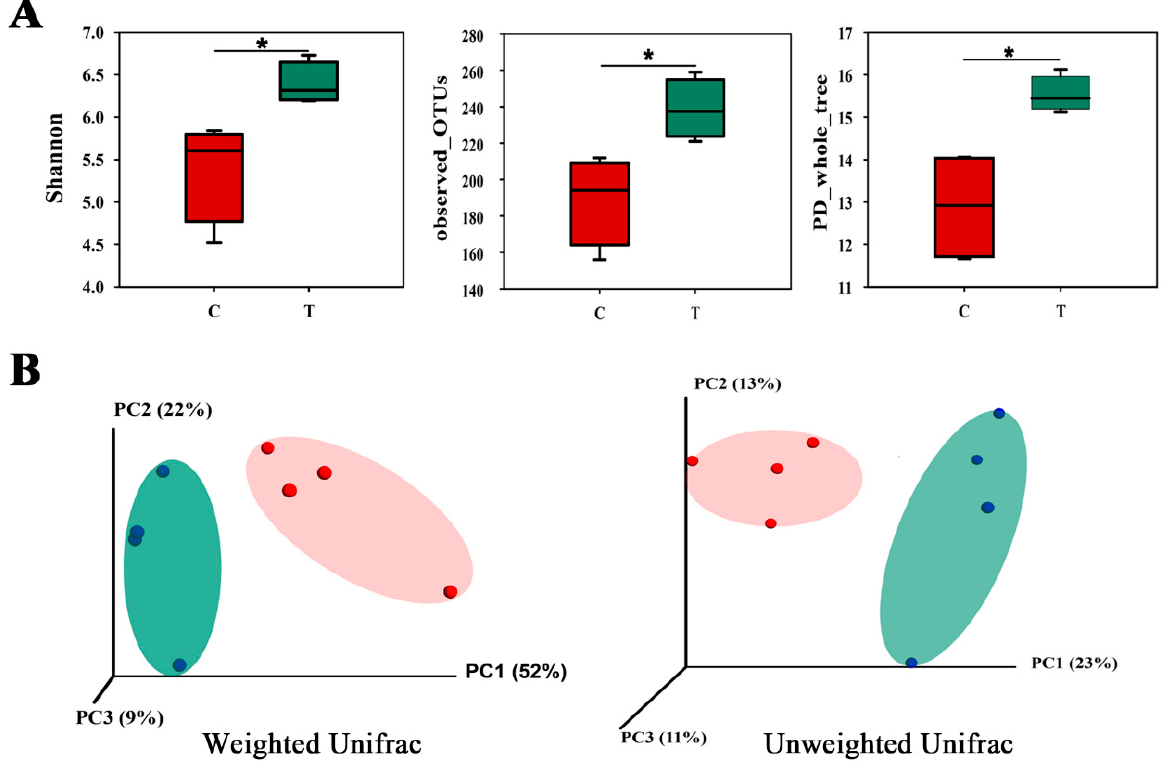
Figure 2. Alpha-diversity and Beta-diversity of Sprague Dawley Rats after CF11 intervention for 21 days. ( A ) Alpha-diversity index (Shannon index, observed_OTUs, and PD_whole_tree) of the gut microbiome in Sprague Dawley Rats, CF11 intervention for 21 days. ( B ) Weighted and unweighted Unifrac distance. Microbial richness estimates and diversity indices were measured at OTUs definition of >97% identity. C (control group, day 21), T (experimental group, day 21), n = 4 each group; Data were analyzed by one-way ANOVA. * p Value < 0.05.